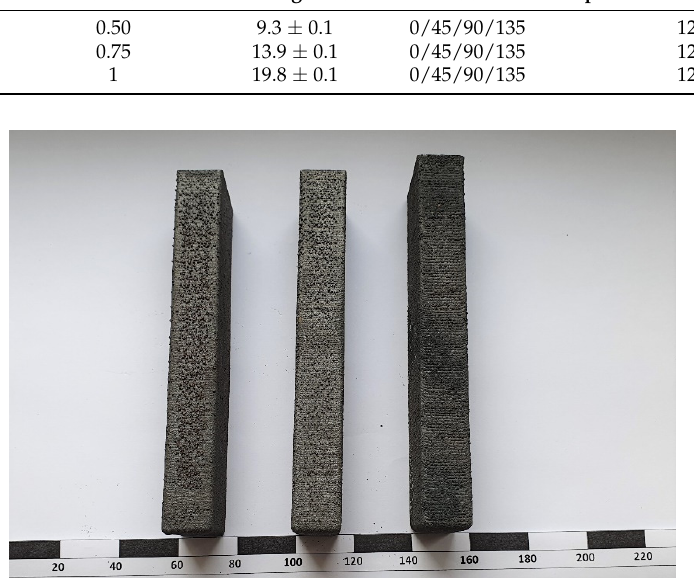
Table 3. Parameters of additive manufacturing process.